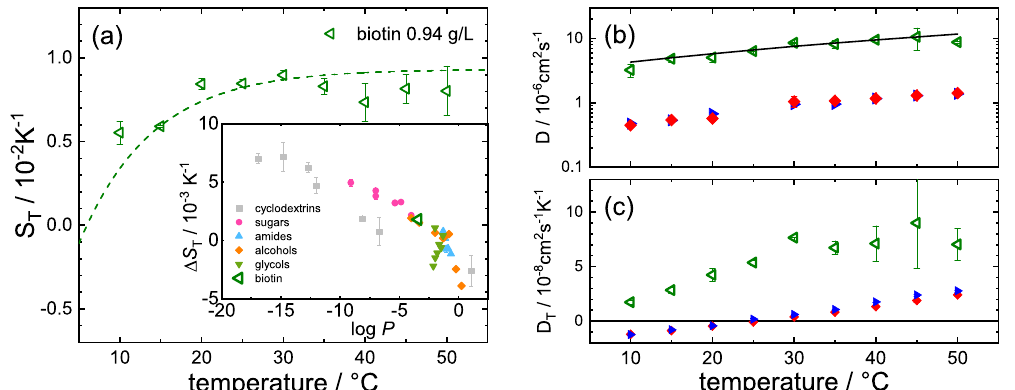
Figure 3. ( a ) Soret coefficient S T of biotin against temperature. The inset shows ∆ S T versus log P for biotin and other substance classes. ( b ) The measured diffusion coefficient D of biotin (green triangles) in comparison with the calculated diffusion coefficient (solid black line). D of STV (blue triangles) and STV + B (red diamonds) is roughly one order of magnitude slower. ( c ) The measured thermal diffusion coefficient D T of biotin (green triangles), of STV (blue triangles) and of STV + B (red diamonds) against